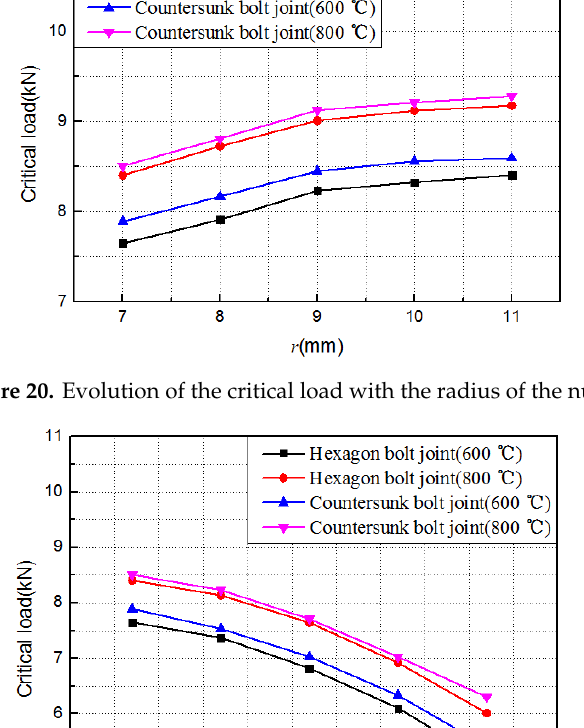
Figure 19. Evolution of the critical load with the temperature.